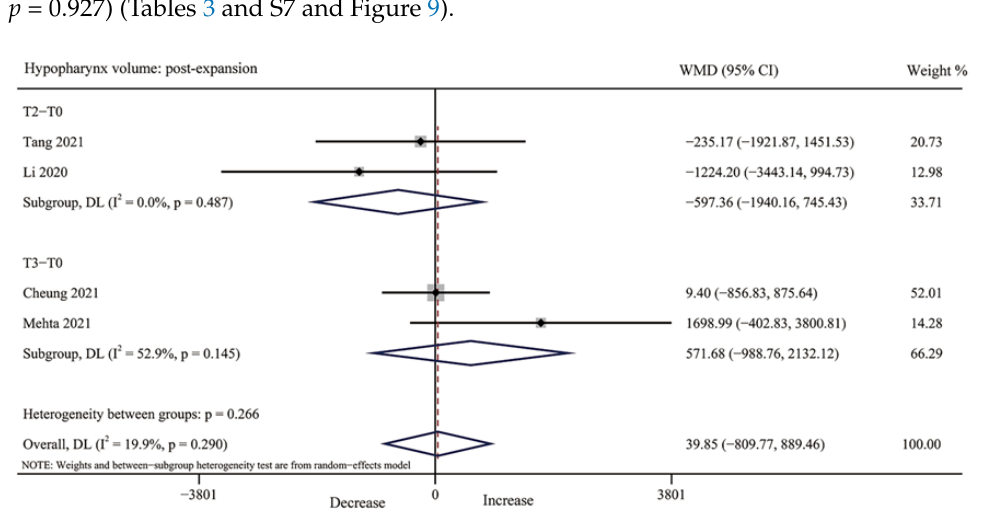
Figure 9. Forest plot for the changes of hypopharynx volume after retention (T2–T3). T0, before expansion; T2, three months after expansion; T3, six months after expansion; WMD, weighted mean difference; CI, confidence interval [35,38,40,42].